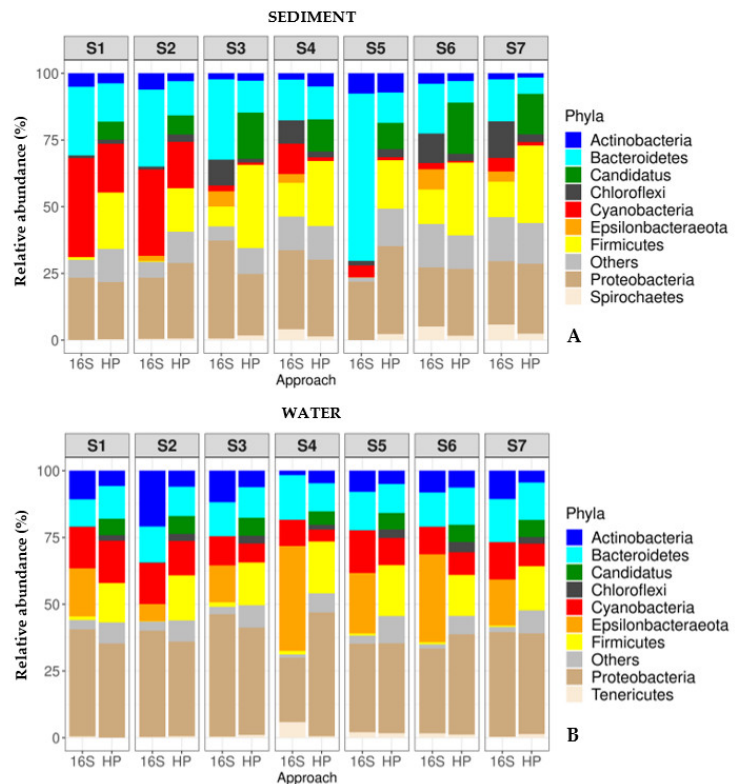
Figure 3. Stacked bar plot representing the relative abundances of bacterial communities (at phyla level) determined by 16S metabarcoding (16S) and phage-host prediction (HP) approach, in the sediment ( A ) and water ( B ) samples of the seven stations (S1–S7). Different bacterial phyla are represented by color code. “Others” in the plots represents a group of bacterial phyla with <1% relative abundances. The relative abundance of bacterial communities (at major phylum level) estimated by both approaches was significantly similar in sediment (Spearman correlation R = 0.5, p-value = 4.4 × 10 −5 ) and in water samples (Spearman correlation R = 0.6, p-value = 7.5 × 10 −8 ) (Figure 4A–B).